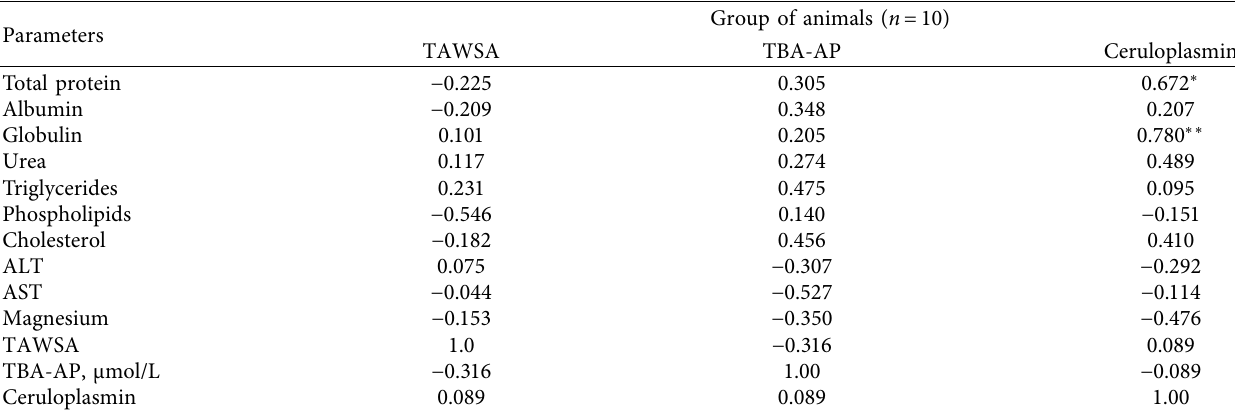
Table 3: Correlation between indicators of metabolic processes and indicators of lipid peroxidation and antioxidant protection in sows. Parameters